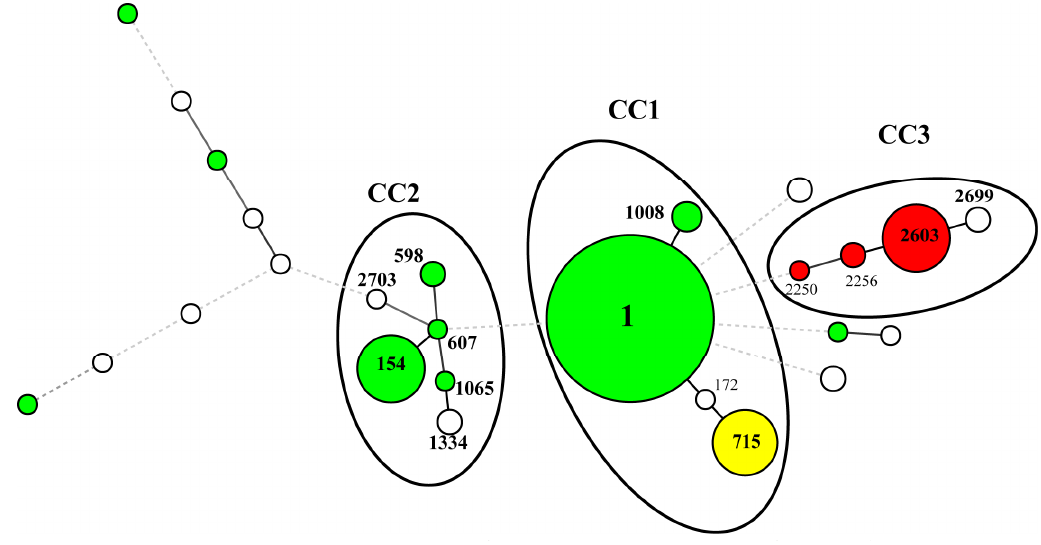
Figure 1. A minimum spanning tree of 161 L. pnuemohila strains from cooling towers in Kobe, Japan, based on SBT. The strains belonged to serogroup (SG)1 ( n = 114), SG13 ( n = 18), SG7 ( n = 13) and the other SGs ( n = 16) were shown as the circles with green, red, yellow, and white respectively. The circle sizes are proportional to the numbers of isolates sharing an identical pattern. The length of the thin line is proportional with single-, double- or triple-locus variants. The dotted lines indicate four loci variants or higher. The clonal complexes (CCs) (CC1, CC2, and CC3) generated with single- and double variants are indicated by the circle surrounding the ST. Whereas KL852 was assigned to ST2703, which differed from ST607 in triple-locus, the strain was included in CC2.